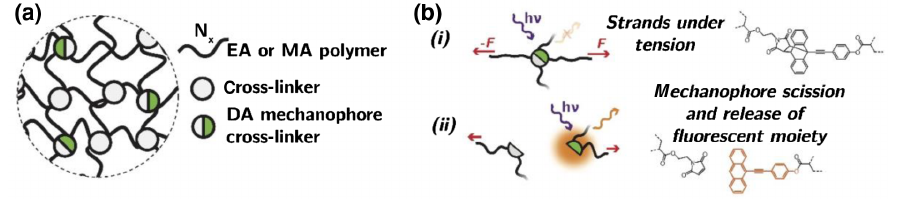
FIG. 2. Strategy for mechanophore incorporation and quantification of the activation. (a) Incorporation of mechanophores at cross-link points in the elastomer network. (b) Mechanophore activation reports for strand scission. (i) Nonfluorescent form of the DA mechanophore, connected to a strand under tension. (ii) Irreversible scission of the mechanophore (retro DA reaction), leading to the release of a fluorescent anthracene moiety, reporting for strand breakage (orange). Dashed bonds show connectivity to the